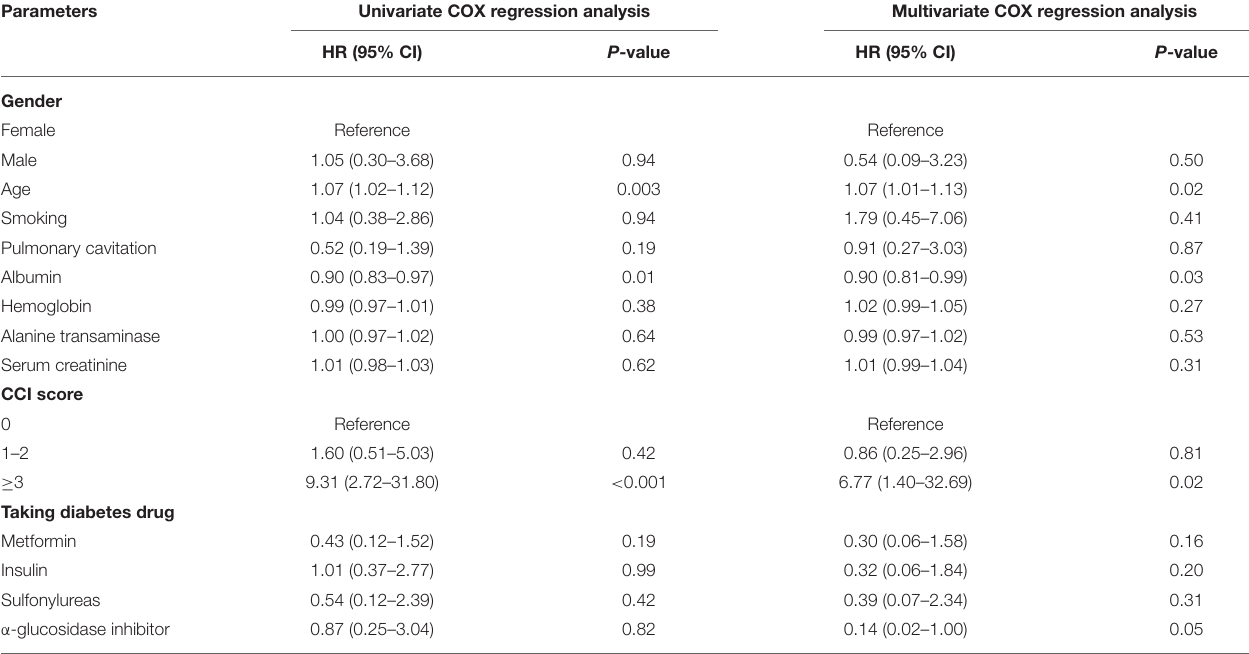
TABLE 2 | COX regression analysis of 1-year all-cause death in patients with pulmonary TB and type 2 diabetes comorbidity. Parameters